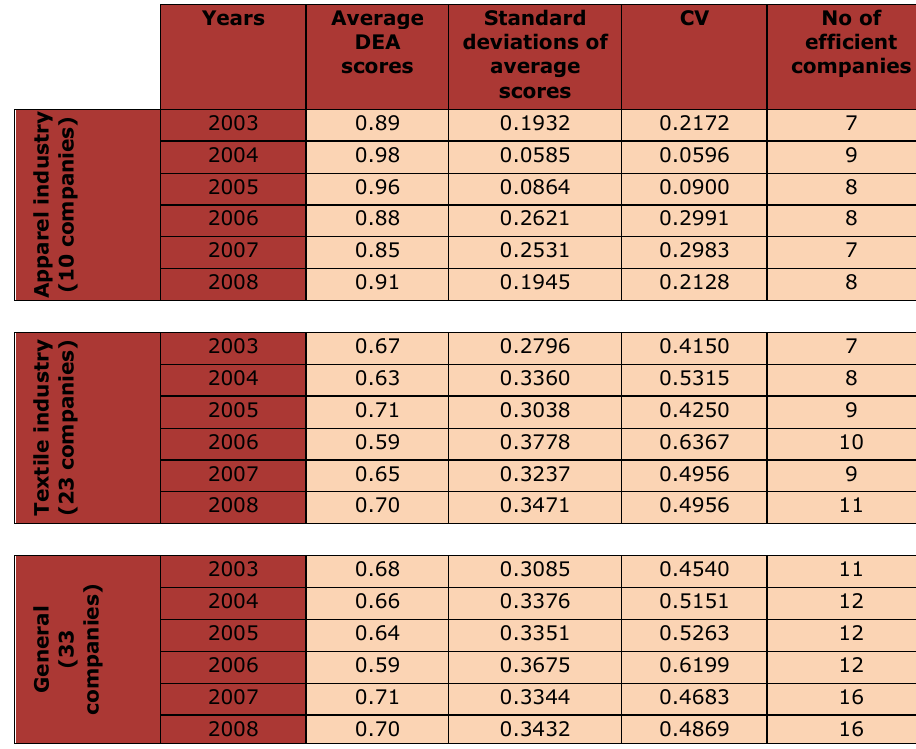
Table 1.DEA Scores, Standard Deviations and CV Values for the Selected